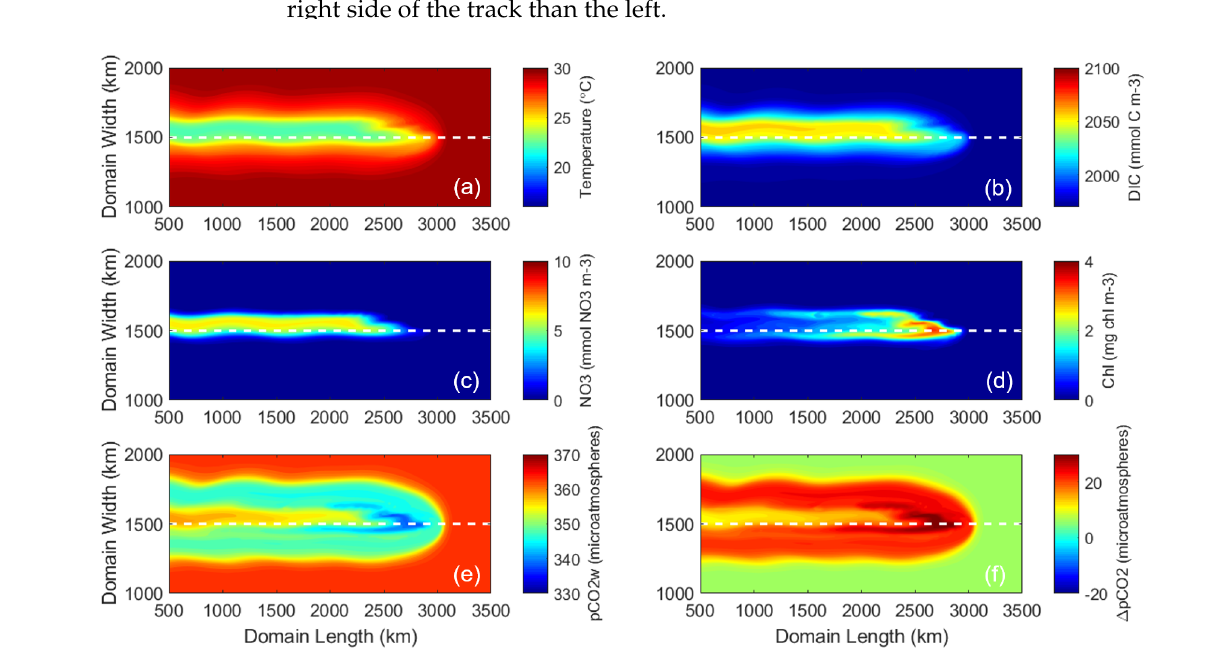
Figure 4. Surface plots of six variables in the control simulation at Day 8, 6 h. ( a ) SST ( ◦ C). ( b ) DIC (mmol m − 3 ). ( c ) NO 3 (mmol m − 3 ). ( d ) Chlorophyll (mg m − 3 ). ( e ) pCO 2 w ( µ atm). ( f ) ∆ pCO 2 ( µ atm), defined as pCO 2 a-pCO 2